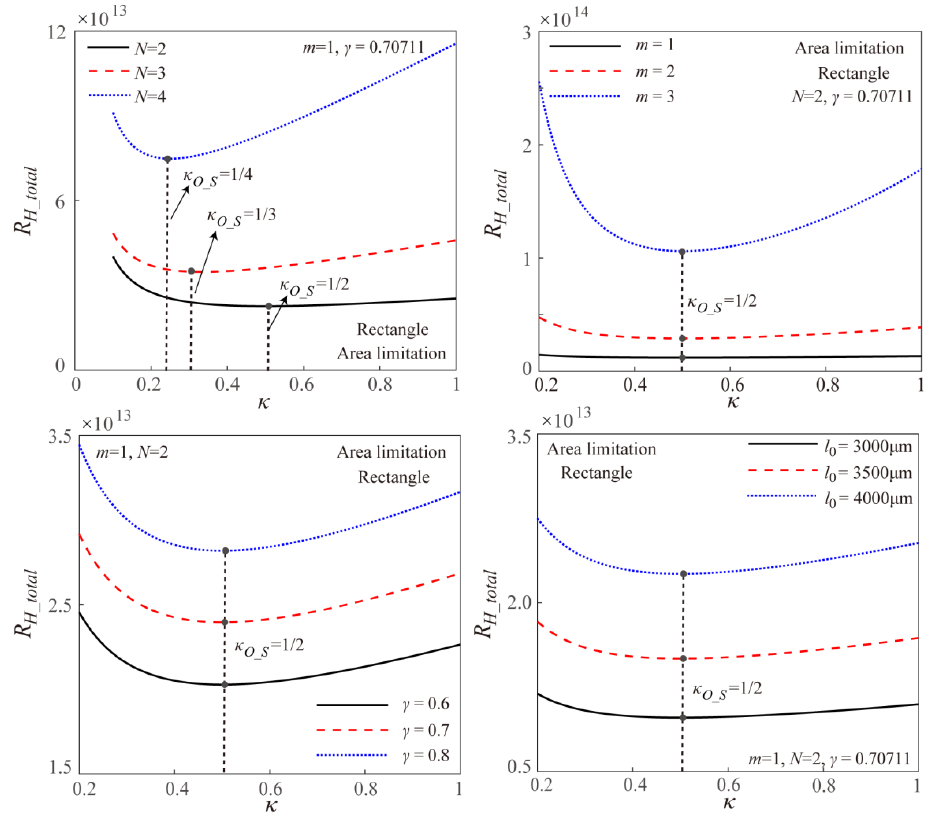
Figure 8. Effects of width ratio on the total EOF fluidic resistance within the symmetric fractal rectangular microchannel network with different N , m , γ, and l 0 under surface area limitation.